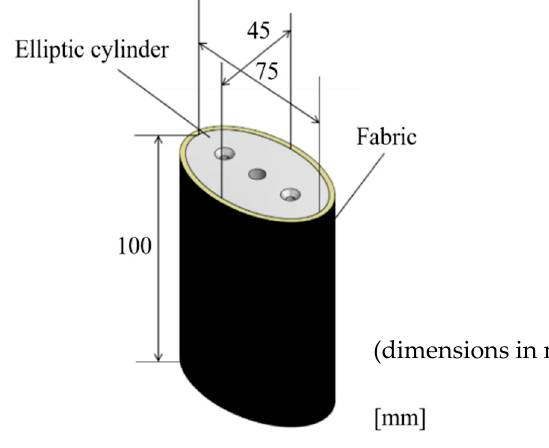
Figure 2. Schematic of elliptic cylinder.